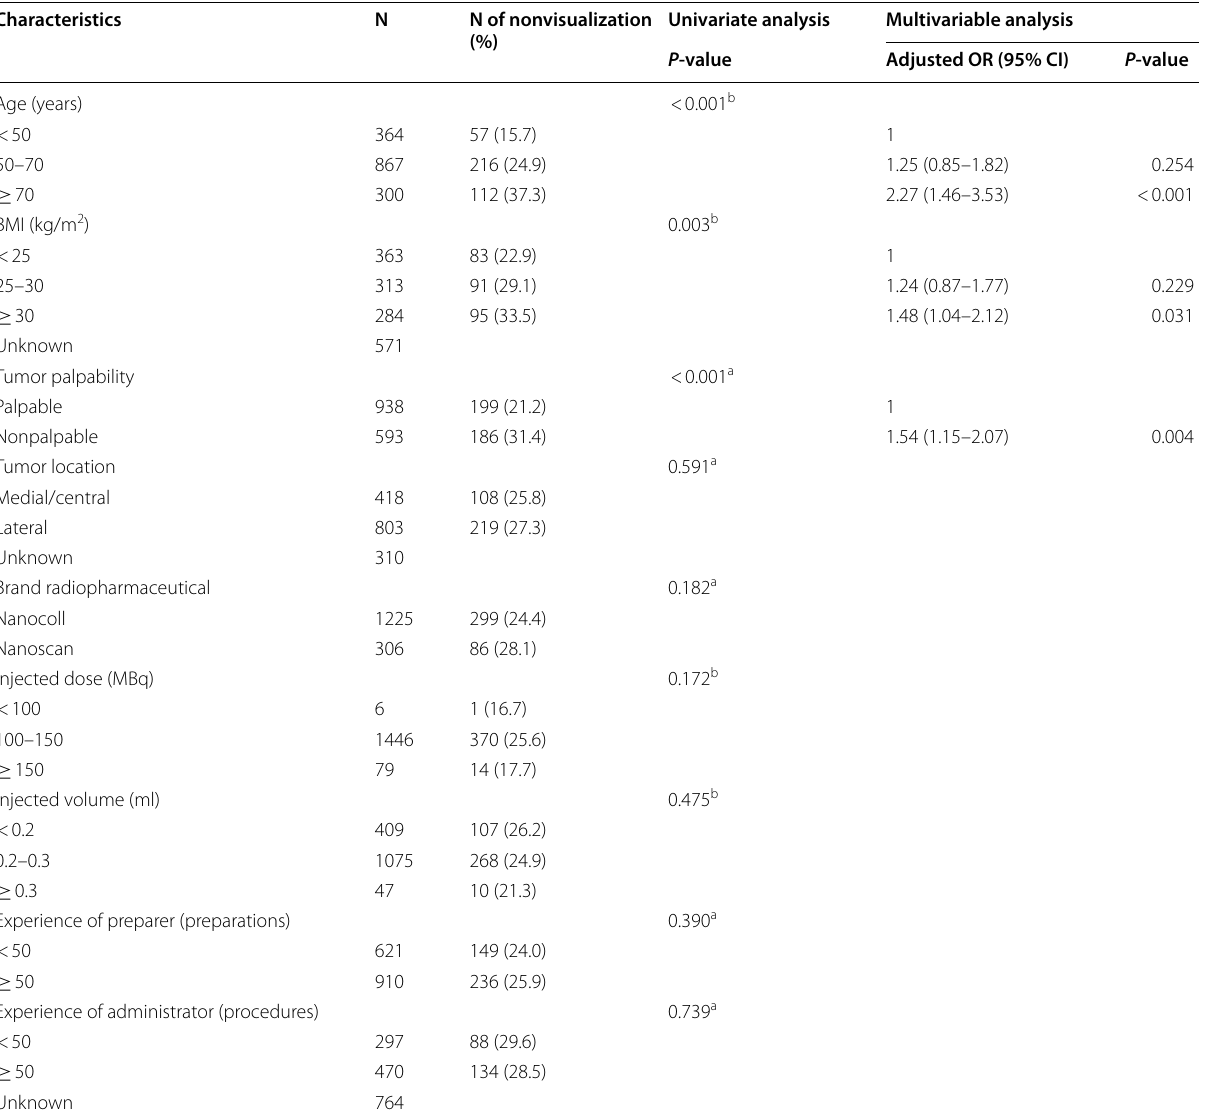
Table 1 Results of multivariable analysis for risk factors of sentinel lymph node nonvisualization on lymphoscintigraphy after initial injection of the radiotracer